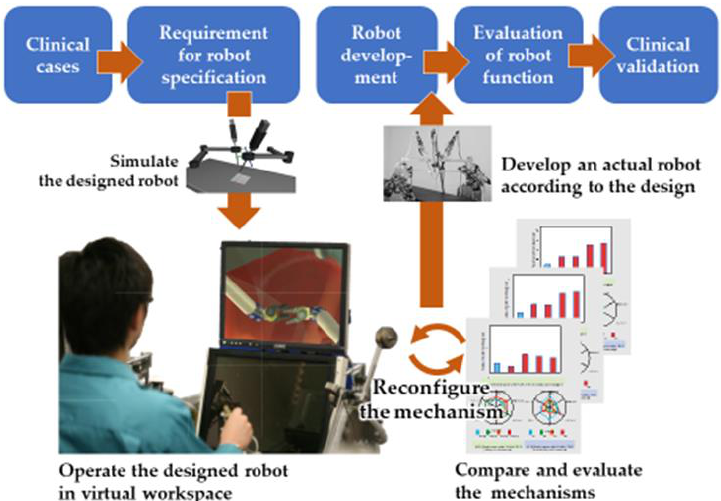
Figure 1. Proposed development process for surgical assisted robot. First, the requirements for the robot were specified. Second, computer-aided design was used to develop the basic mechanism of the robot. Third, the robot and the surgical environment were reproduced in the virtual workspace. Fourth, the mechanical design parameters of the robot were evaluated by comparing the different mechanisms with the surgeon’s operations. The parameters were optimized by the results of tool trajectories and invisible areas in the endoscopic view. The modified mechanism was then re- evaluated.